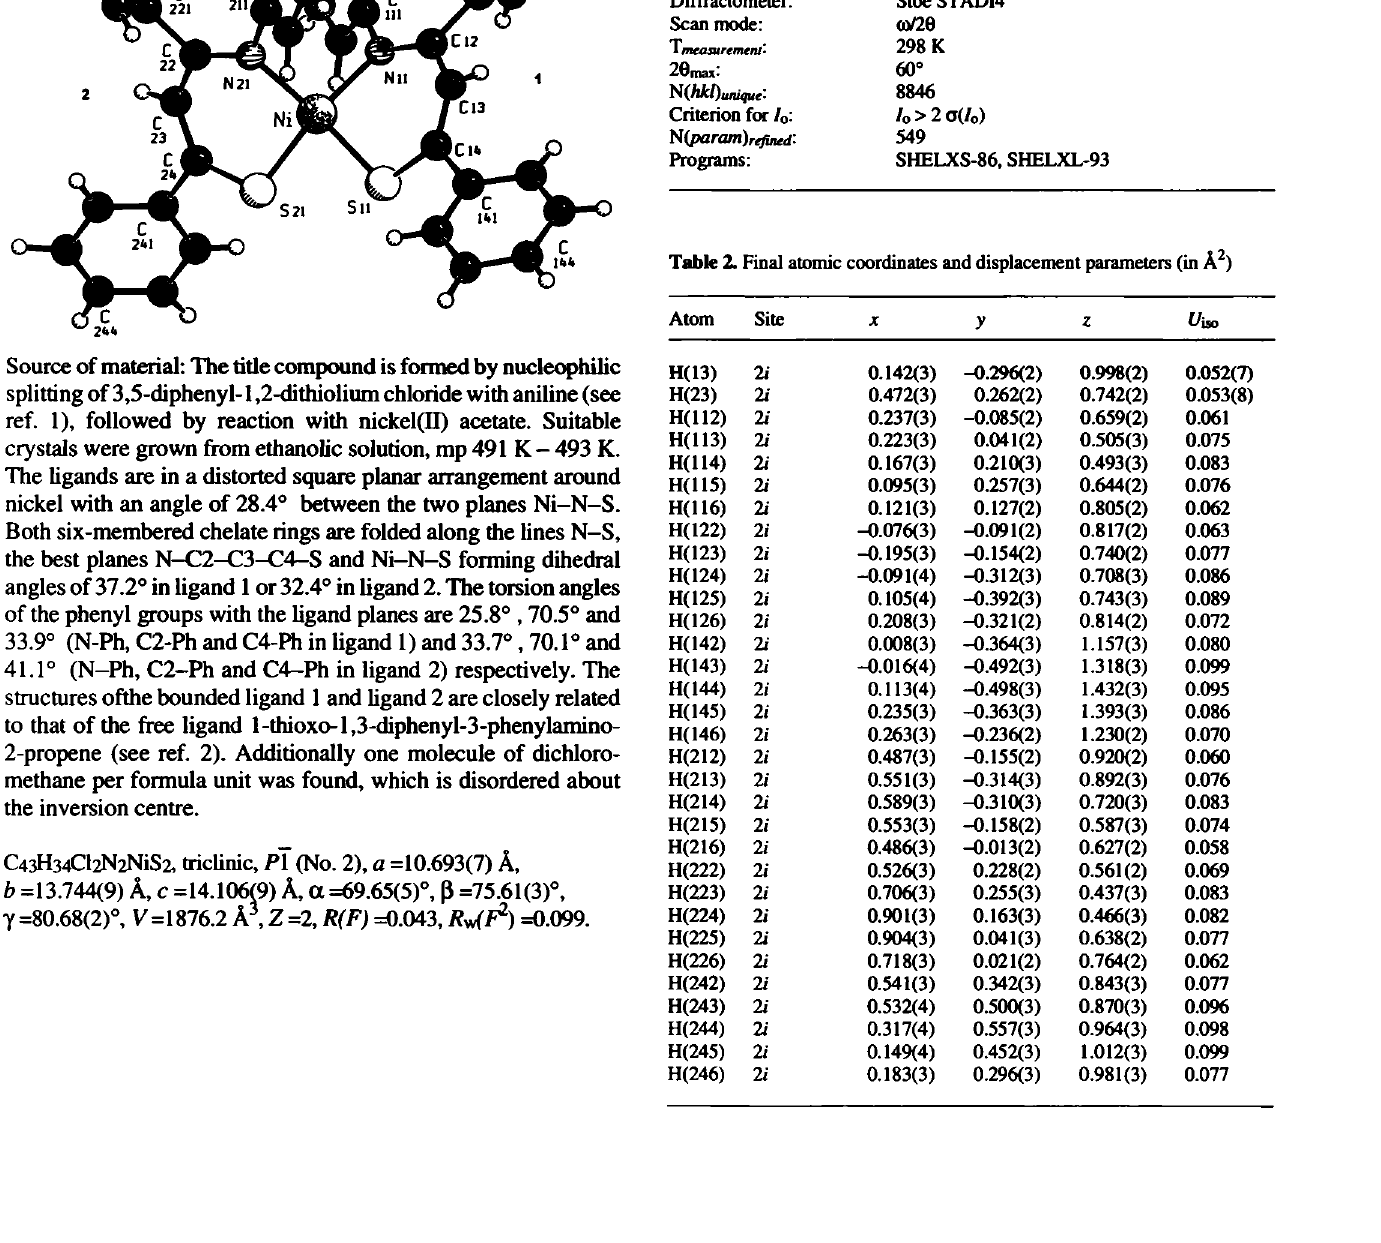
Table 1. Parameters used for the X-ray data collection